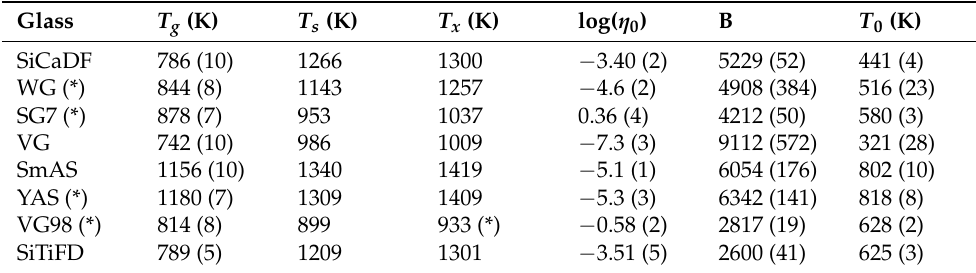
Table 2. From the DTA measurements (this work): T g values, temperature of crystallization start T s , and crystallization peak T x for each glass. (*): slight crystallization is observed above T g . From the VFT fittings (this work): parameters log( η 0 ), B, and T 0 . In brackets: measurement or fitting errors in last